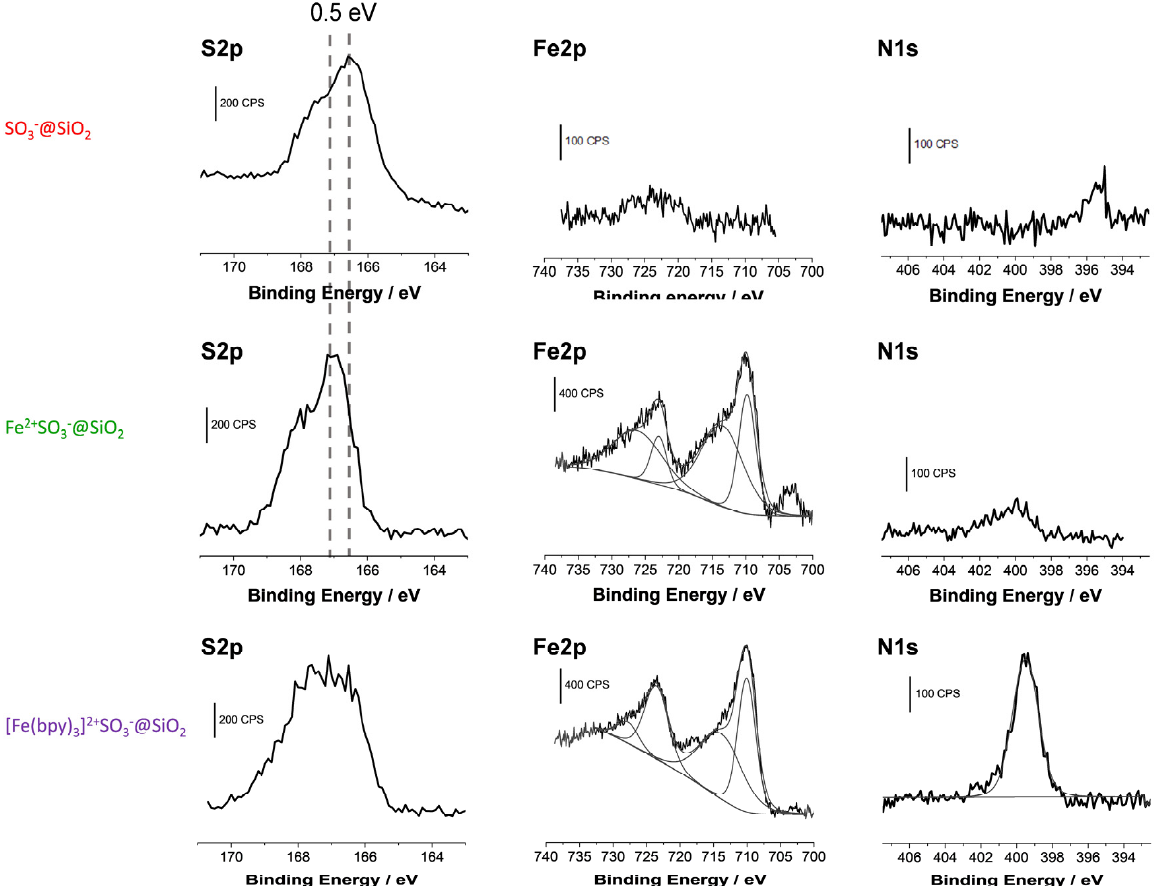
Figure 3. S2p (left), Fe2p (center) and N1s (right) core level spectra recorded for 20/80 films, respec- tively, functionalized with sulfonate groups (SO 3- @SiO 2 , top), after complexation with iron (II) (Fe 2+ SO 3- @SiO 2 , middle) and after Fe 2+ complexation and bipyridine displacement of aquo ligands ([Fe(bpy) 3 ] 2+ SO 3- @SiO 2 , bottom). Table 1. Atomic composition (% At.) and binding energies (BE) for the functionalized mesoporous silica films at each step of the modification process (data obtained from the XPS measurements).